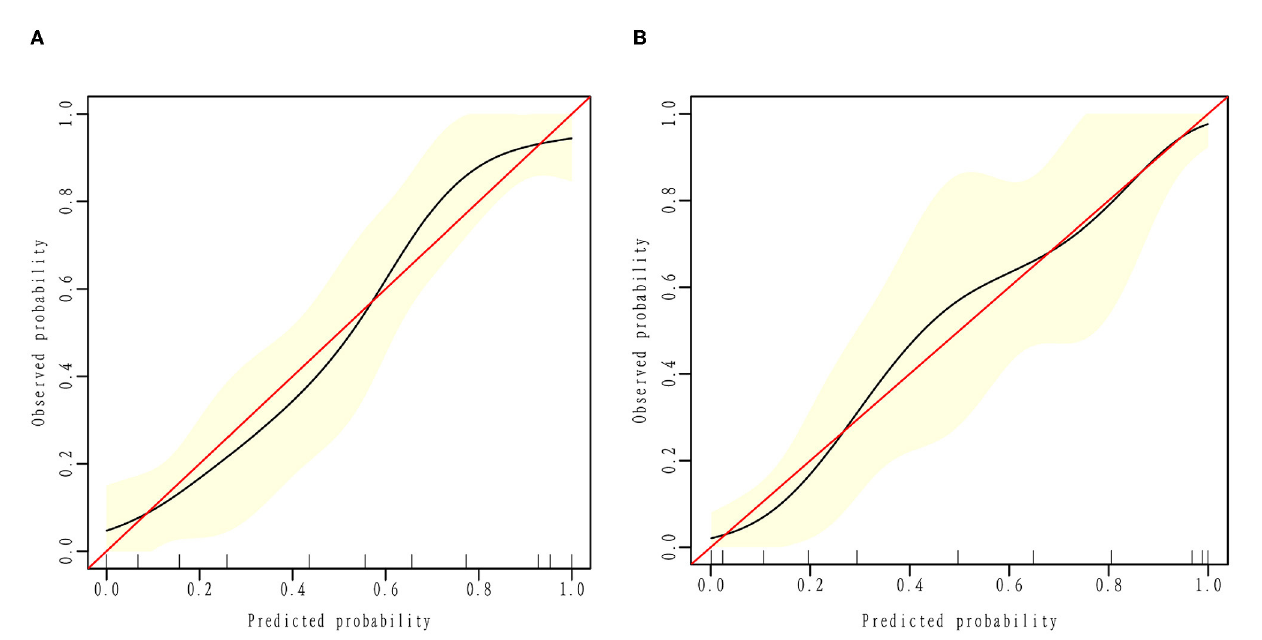
FIGURE3 Calibration curve. The black calibration curve shows the predicted proportion of clinical outcomes against the actual probability of outcomes. The red line demonstrates the actual risk equal to the predicted risk. Calibration plots for estimating improved outcome probabilities are presented for the training (A) and validation cohorts (B)